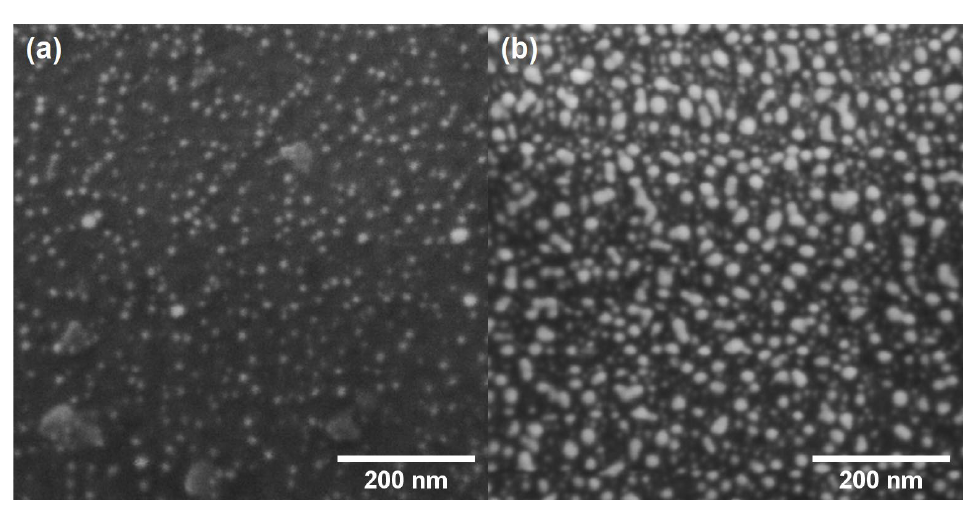
Figure 1. The SEM micrographs of the surfaces of samples Pt100 ( a ) and Pt200 ( b ). After the Al 2 O 3 and Pt ALD processes, the grain size and grain distribution in the NiTi layer